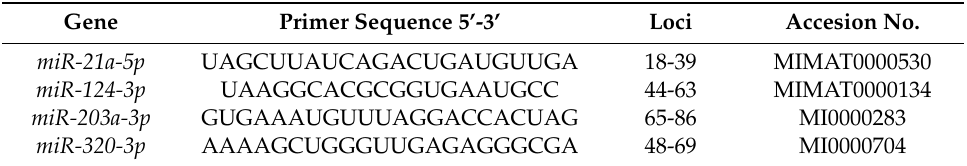
Table 2. List of primers used in RT-qPCR for miRNA.